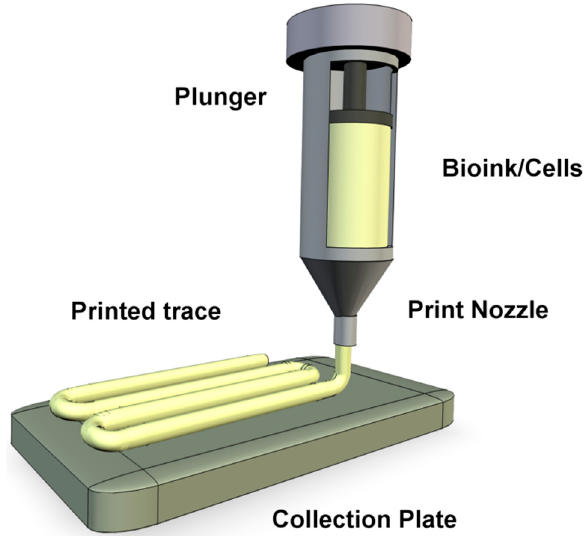
Figure 2. A representation of the extrusion bioprinting of stem cells. A stem cell bearing bioink is forced from a syringe reservoir and deposited as an extended trace on the collection plate.